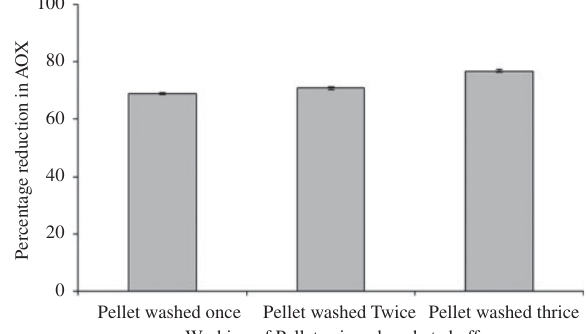
Fig. 3. Effect of rate of inoculum size on the AOX reduction of pulp and paper mill effluent